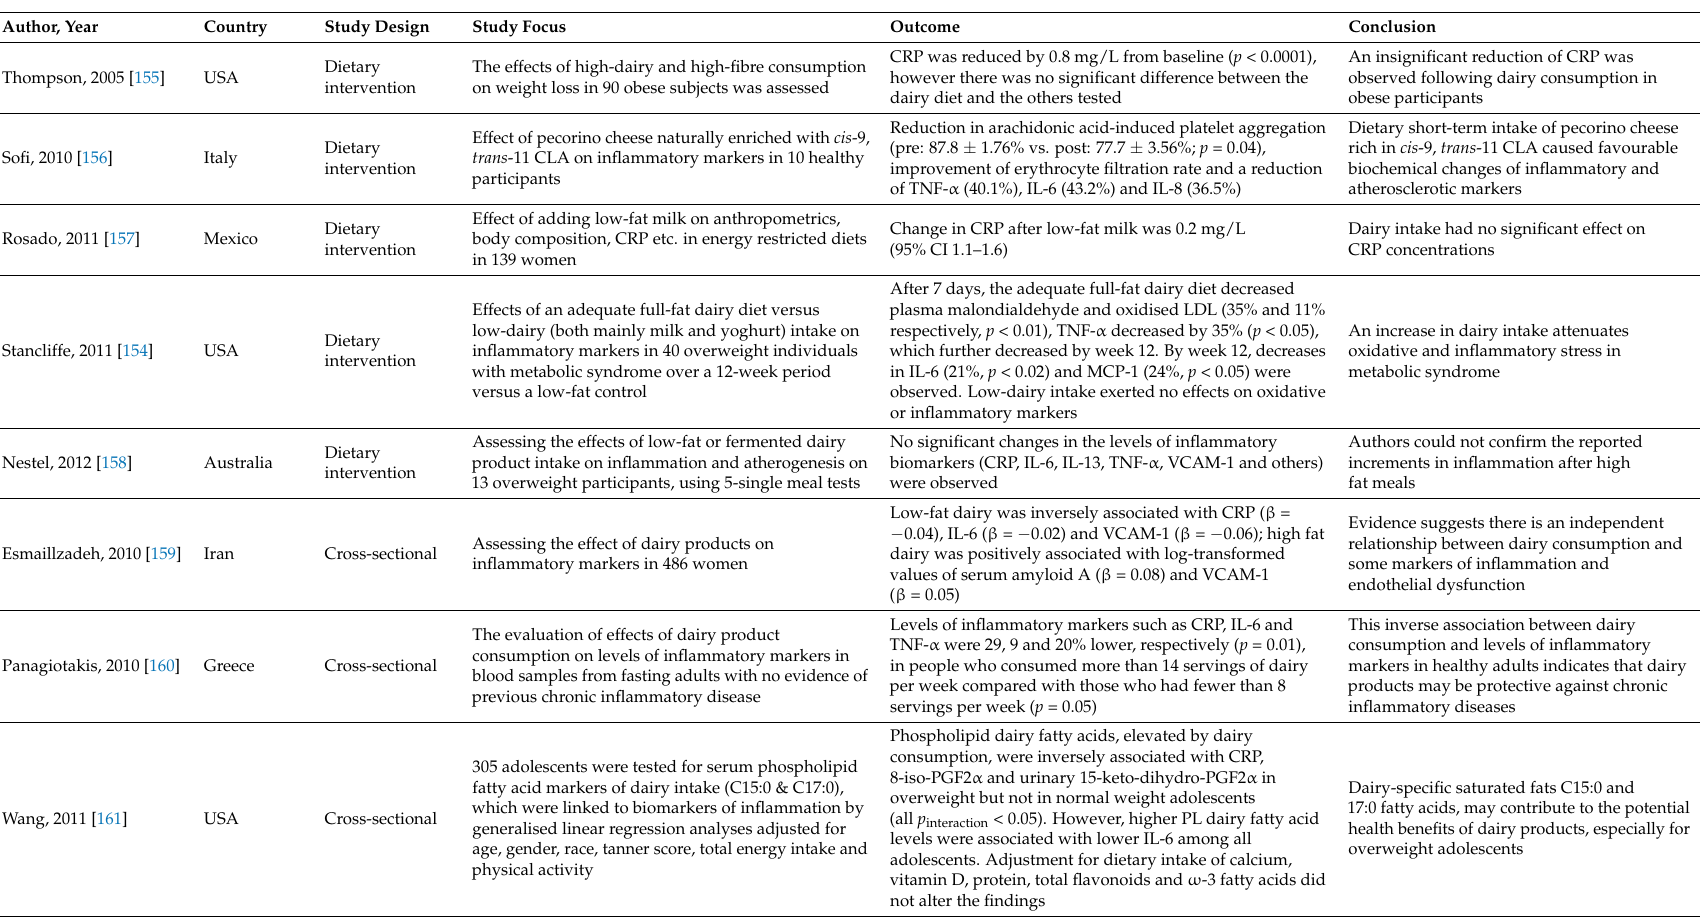
Table 1. Summary of the findings of observational studies investigating the consumption of dairy products and their derivatives on inflammatory markers related to cardiovascular diseases, obesity and metabolic syndrome in healthy and diseased